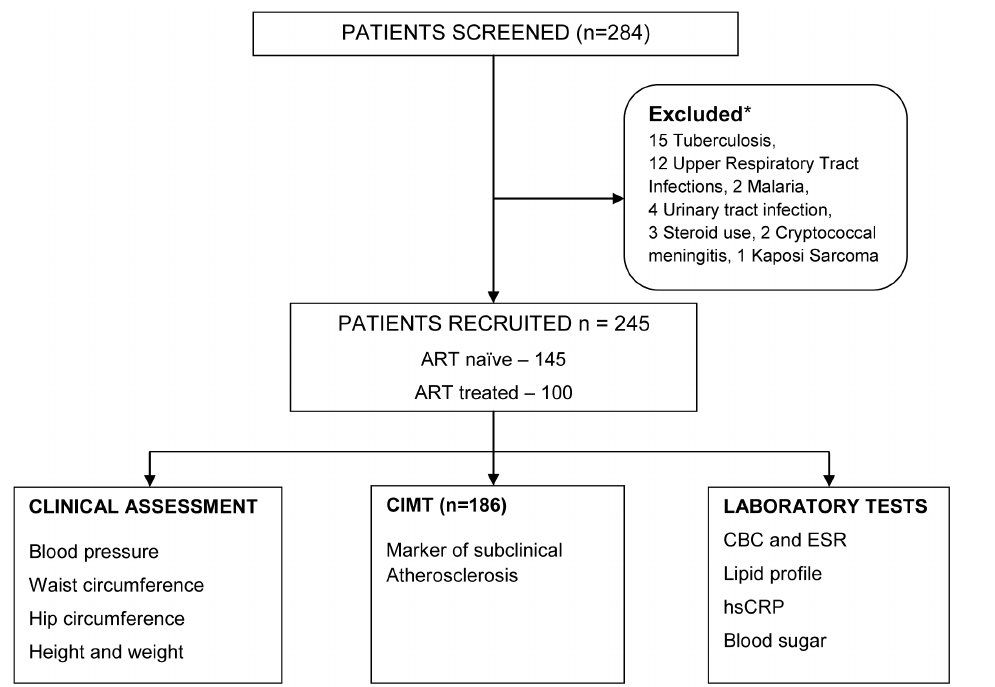
Figure 1. Flow diagram showing HIV-infected adults that participated in the study. * 36 patients with confirmed active disease and 3 patients receiving steroid therapy were excluded. ART: Anti retroviral therapy, CIMT: Carotid intimal medial thickness, CBC: Complete blood count, ESR: Erythrocyte sedimentation rate, hsCRP: high sensitivity C-reactive protein.